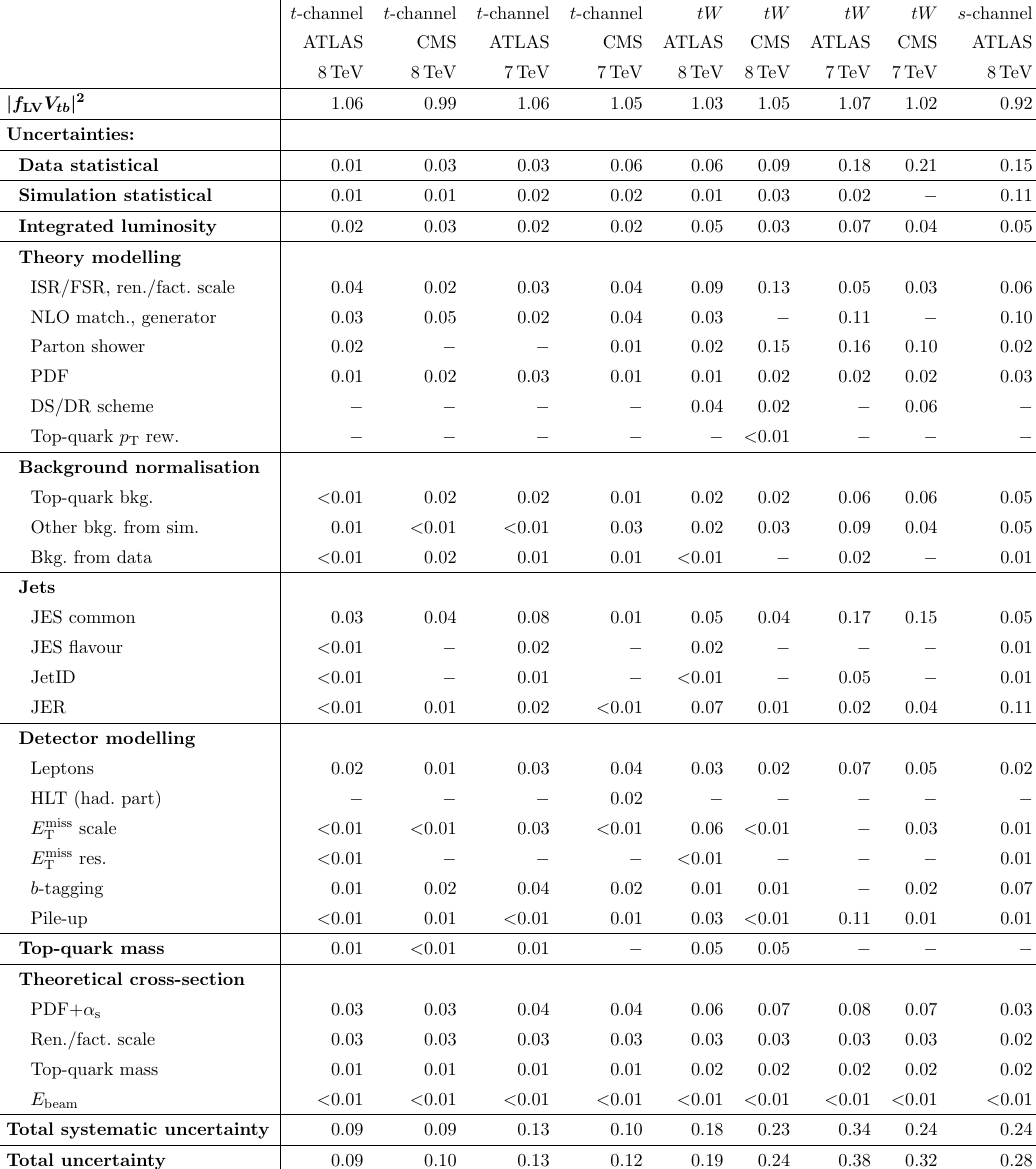
2 determinations that are the inputs f LV V tb j j mean that this uncertainty was (cid:0)